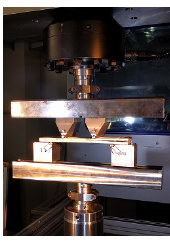
Figure 7. Mode II testing